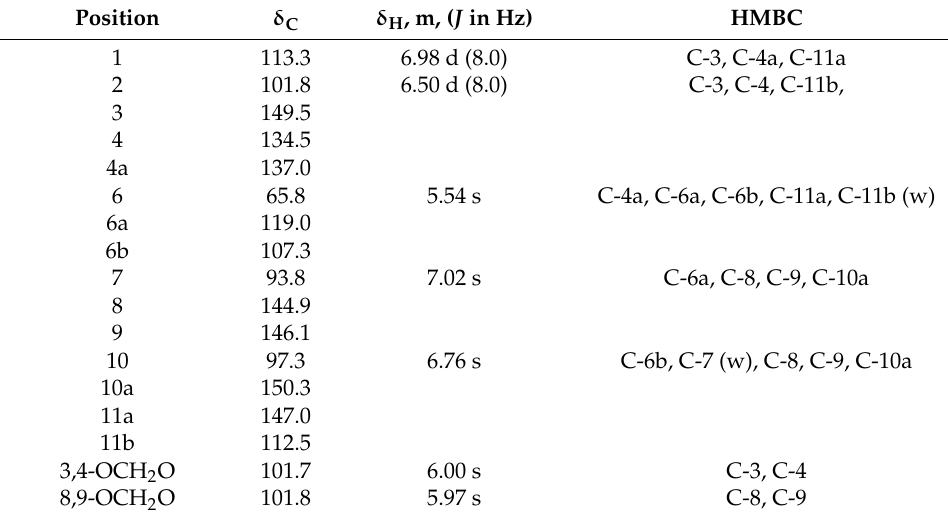
Table 3. 1 H (600 MHz) and 13 C (150 MHz) NMR data for 3,4:8,9-dimethylenedioxypterocarpene ( 4 ) acquired in CD 2 Cl 2 at 25 ◦